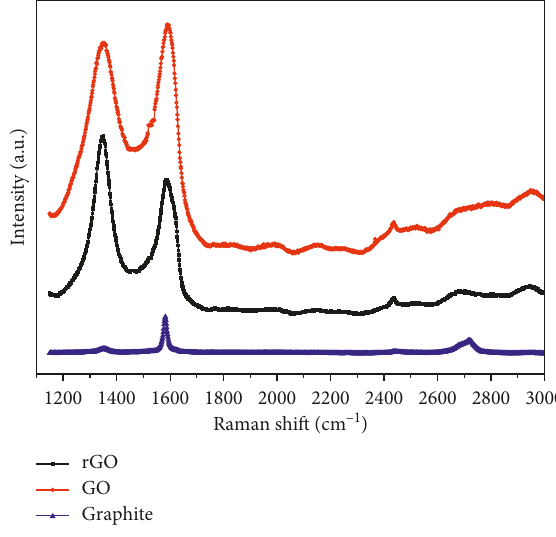
Figure 2: Raman spectra of graphite, GO, and